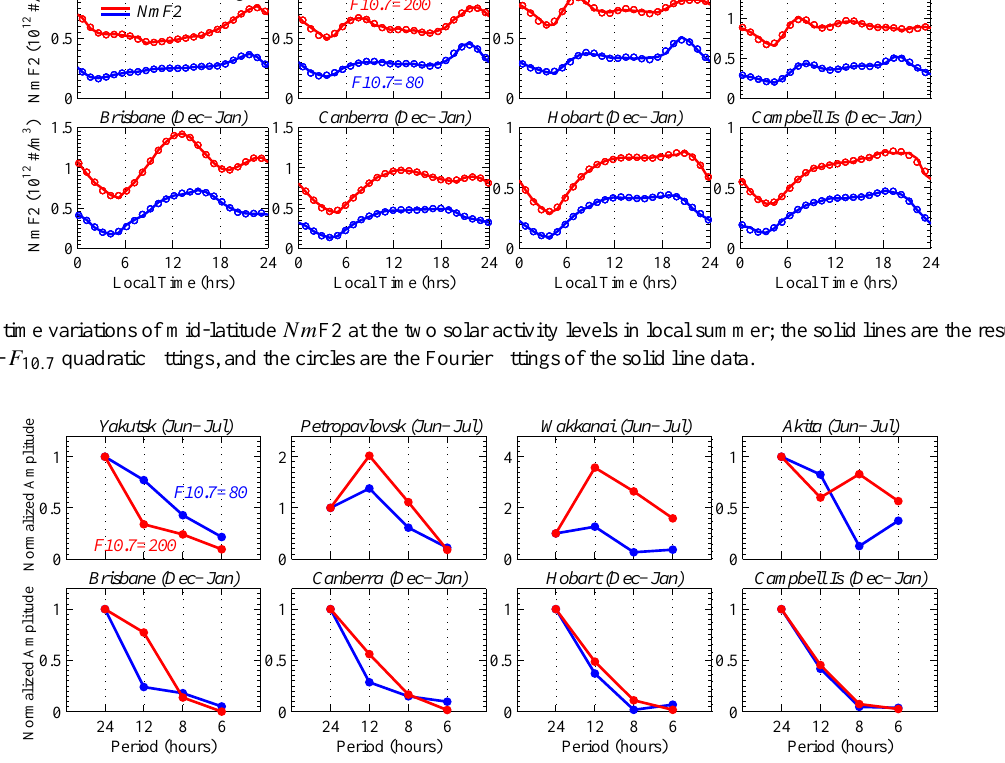
Figure 4. Normalized amplitudes of the Fourier components of Nm F2 diurnal variations; for each station the amplitudes are normalized with the 24h component